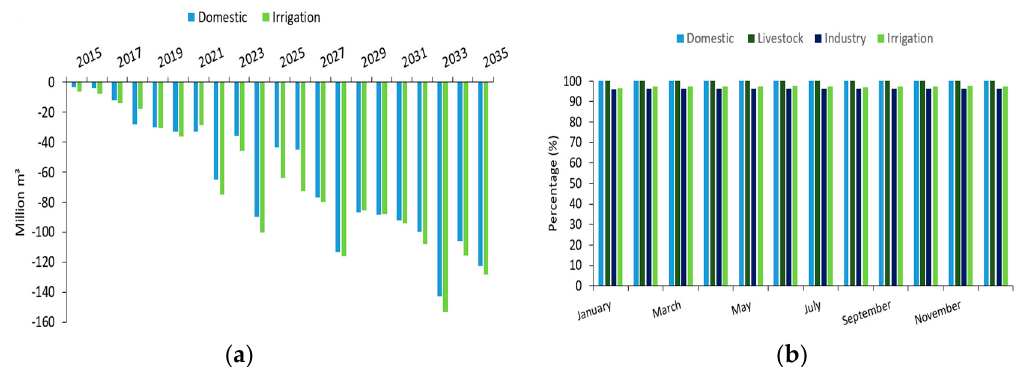
Figure 6. ( a ) Sectorial unmet demands under the Current Trend (CT) scenario, and ( b ) sectorial demand coverage under the Demand Side Management (DSM) strategies.